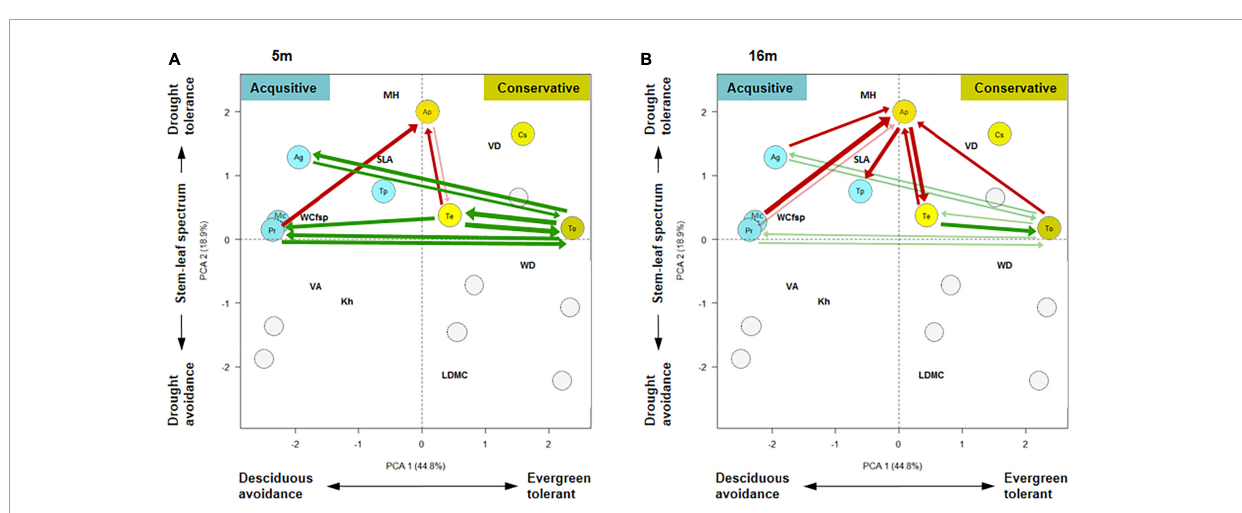
FIGURE4 Allocation of significant spatial species associations within the space spanned by the first two axes of the trait space. (A,B) Shows species associations at small (5 m) and medium (16) scales, respectively. The width of the arrows is proportional to the strength of the association. Red arrows indicate significant and negative spatial species associations of the segregation type, and green arrows significant and positive ones of the mixing type. The arrows of the species pairs go from the focal species to the second species, and species pairs with two arrows are symmetric. Transparent arrows (light green or red) are just non-significant with an association strength > 2. Gray transparent circles shows the allocation of other 7 species that were not included in this analysis because they had less than 35 large